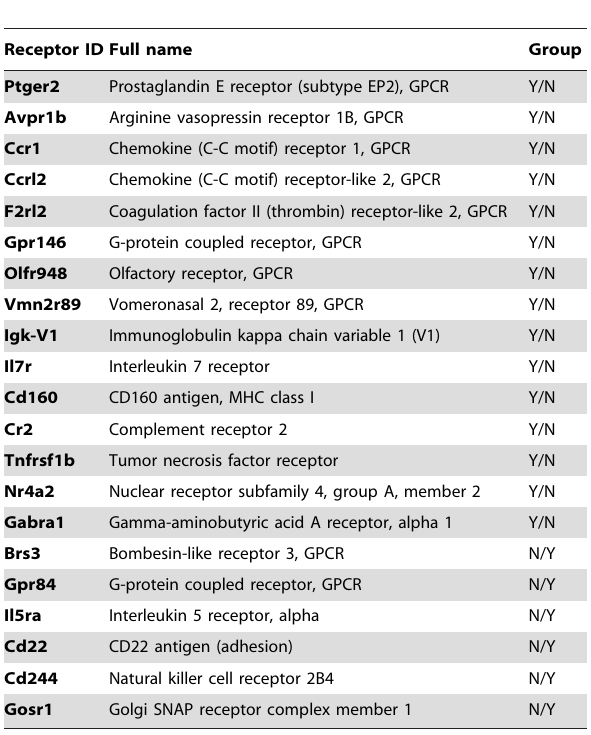
Table 2. Receptor genes expressed in YES/NO and NO/YES sub -regions of